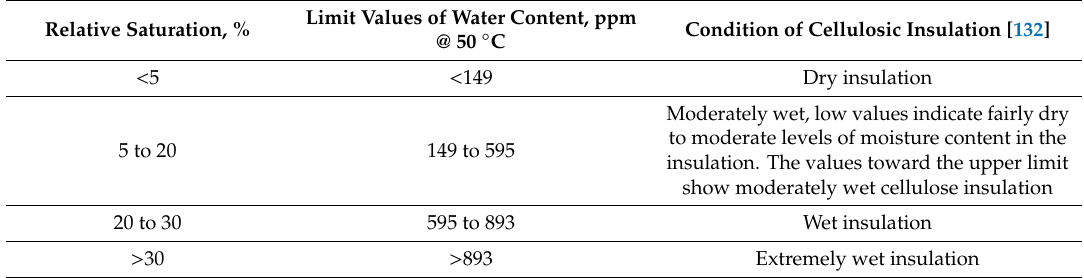
Table 6. The guidelines for interpreting the condition of cellulose insulation on the basis of water content in synthetic